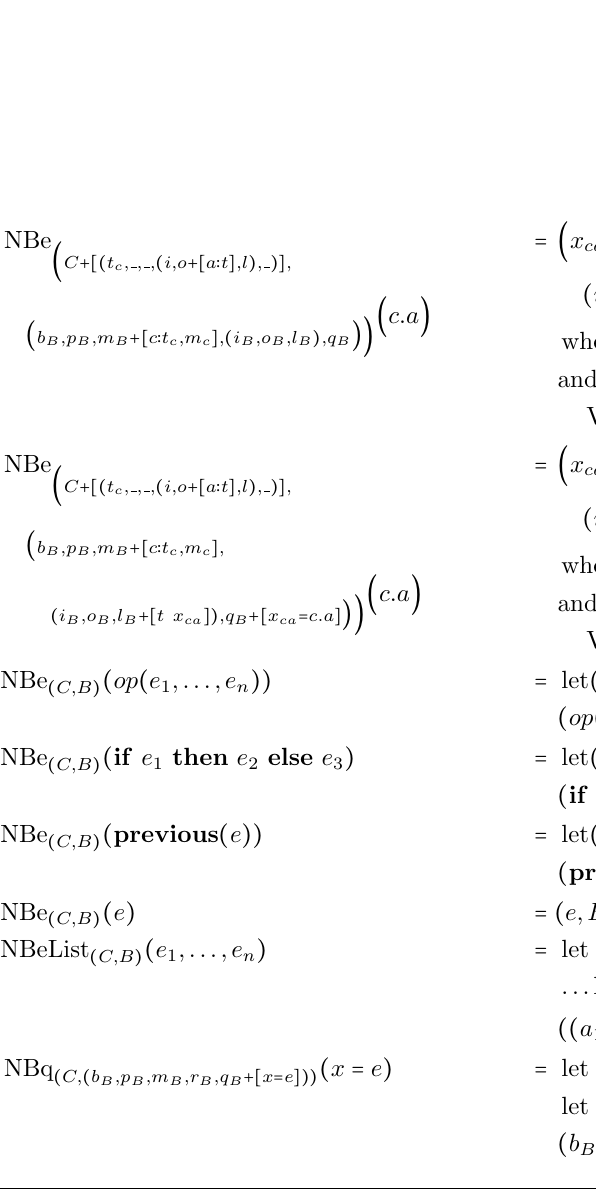
Figure 21: Function NBq—Normalize RHS component dot access in equations. The RHS expression e is tra- versed by function NBe. An occurrence of a component dot accesses c.a in e is extracted and a fresh (decorated) variable x ca = dn ( a ) is introduced and bound to c.a in a new equation x ca = c.a . The D,c ) ( component dot access c.a in e is then replaced by x ca . It is also checked whether c.a already is asso- ciated to an equation x ca = c.a — in that case no fresh variable is introduced and x ca is reused. This ensures that any component dot access c.a is uniquely associated to exactly one equation x ca = c.a